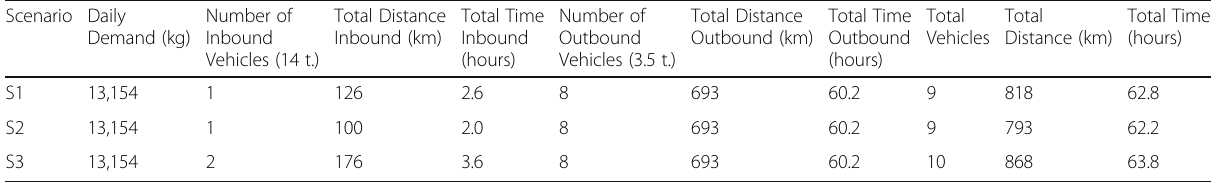
Table 3 Travelled distances and times for the three assessed scenarios calculated by VRP-SS Scenario Daily Number of Demand (kg) Inbound Vehicles (14 t.)